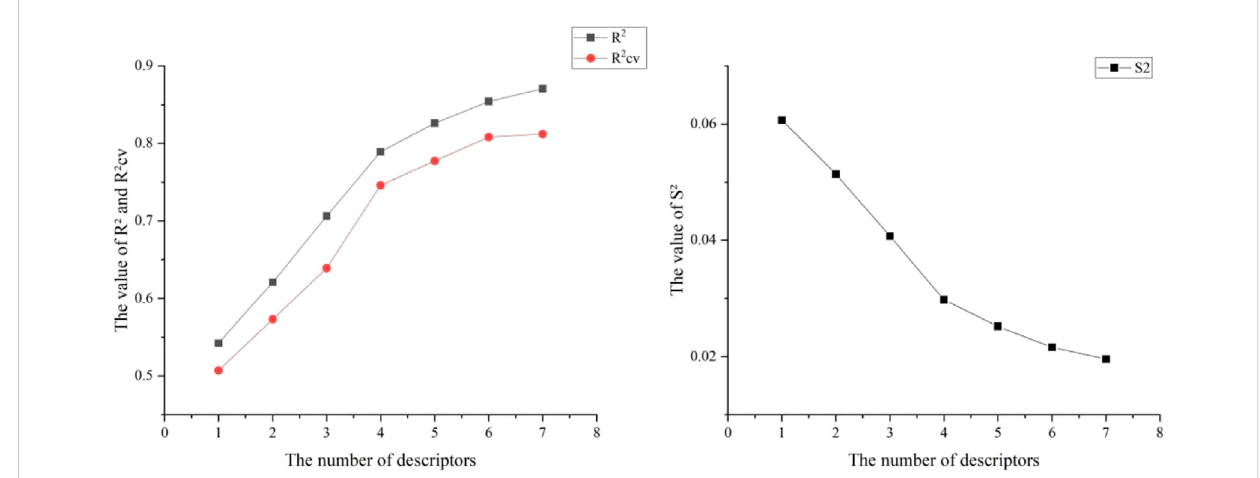
FIGURE 3 Relationship between R 2 , R 2 cv, S 2 and different numbers of descriptors.